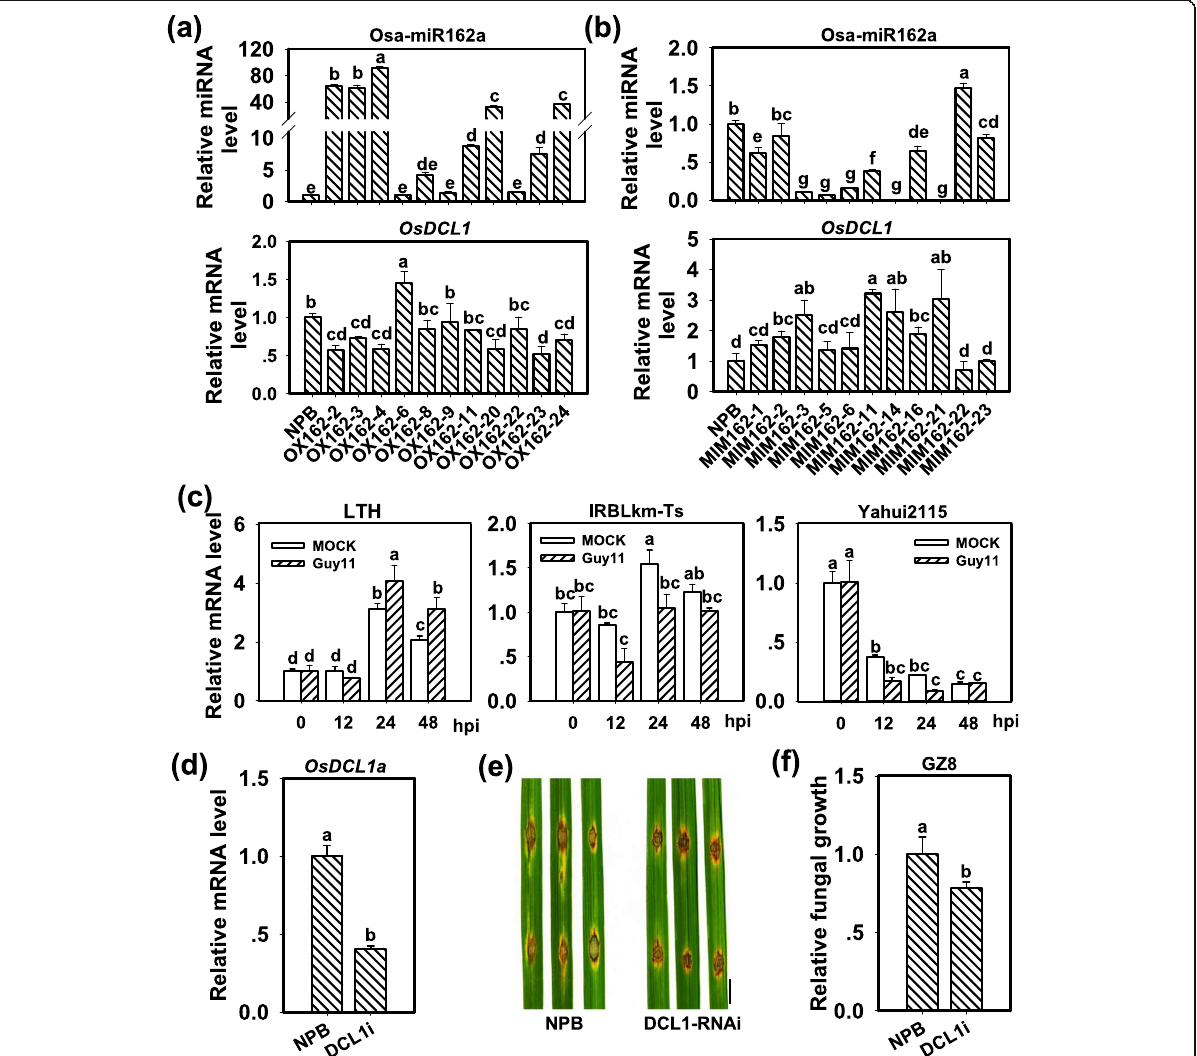
Fig. 7 OsDCL1 negatively regulates rice blast resistance. a and b Amounts of Osa-miR162a and mRNA levels of OsDCL1 in OX162 ( a ) and MIM162 lines ( b ) in comparison with Nipponbare (NPB). Total RNA was used to carry out reverse-transcription (RT) with an Osa-miR162 specific stem-loop RT primer (Additional file 4: Table S1), and the RT product was subsequently used as a template for quantitative polymerase chain reaction (q- PCR) to detect the amounts of Osa-miR162. snRNA U6 served as an internal reference. c Expression of OsDCL1 in susceptible accession LTH and resistance accessions (IRBLKm-Ts and Yahui2115) with or without M. oryzae strain Guy11 infection. RNA was extracted at the indicated time points for qRT-PCR analysis. The relative mRNA levels were normalized with the mRNA level of the mock sample at 0 hpi. d mRNA levels of OsDCL1 in OsDCL1 RNA inference transgenic line (DCL1i) and NPB plants. e Blast disease phenotypes on leaves of DCL1i and NPB at 5 days post-inoculation (dpi) of M. oryzae strain GZ8. Bar = 5 mm. f Quantification analysis of the fungal biomass in ( e ). Relative fungal biomass was measured by using the ratio of DNA level of M. oryzae Pot2 gene against the rice genomic ubiquitin DNA level. For a, b, c, d, and f, error bars indicate SD (n = 3). Different letters above the bars indicate a significant difference ( P < 0.05) as determined by a one-way ANOVA analysis. All the experiments were repeated two times with similar